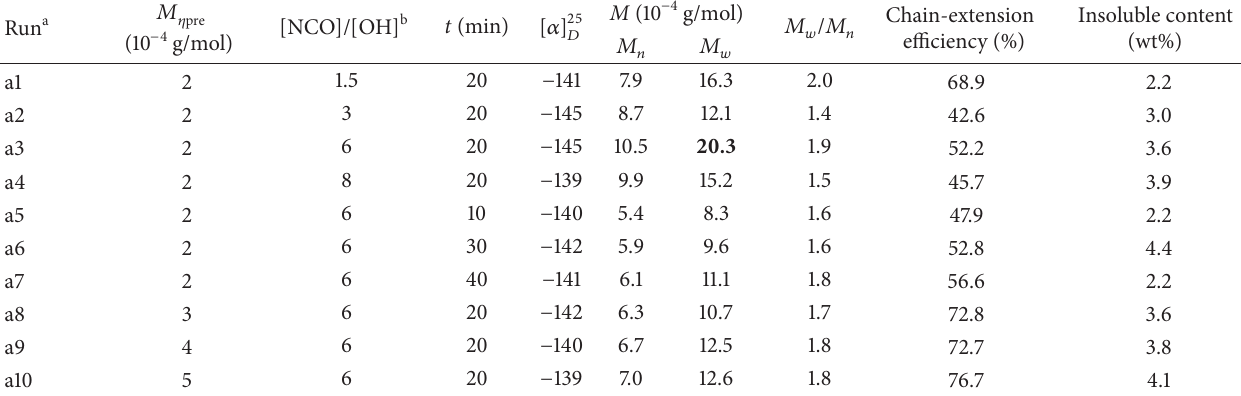
Table 1: The influences of process conditions on poly(lactic acid) after chain